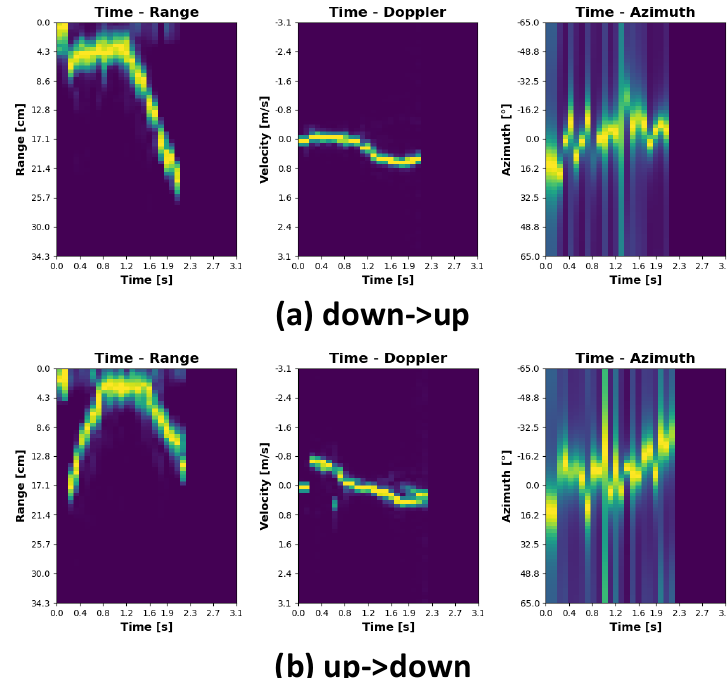
Figure 8. Gesture